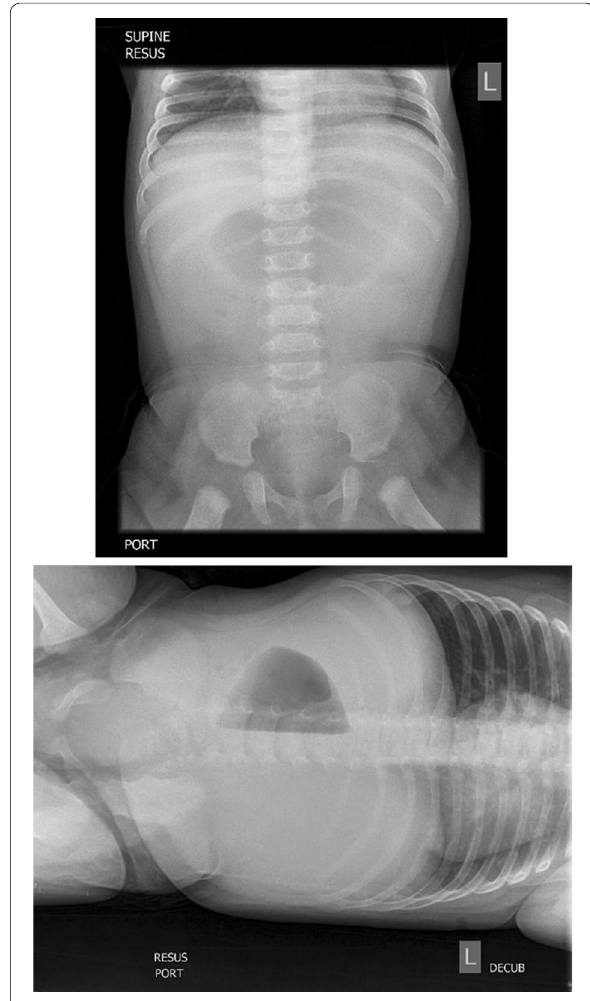
Fig. 2 Abdominal X‑rays: supine and left lateral decubitus radio‑ graphs showing a gasless abdominal field except in the gastric area. There were no obvious radiographic features of peumatosis or intus‑ susception for the